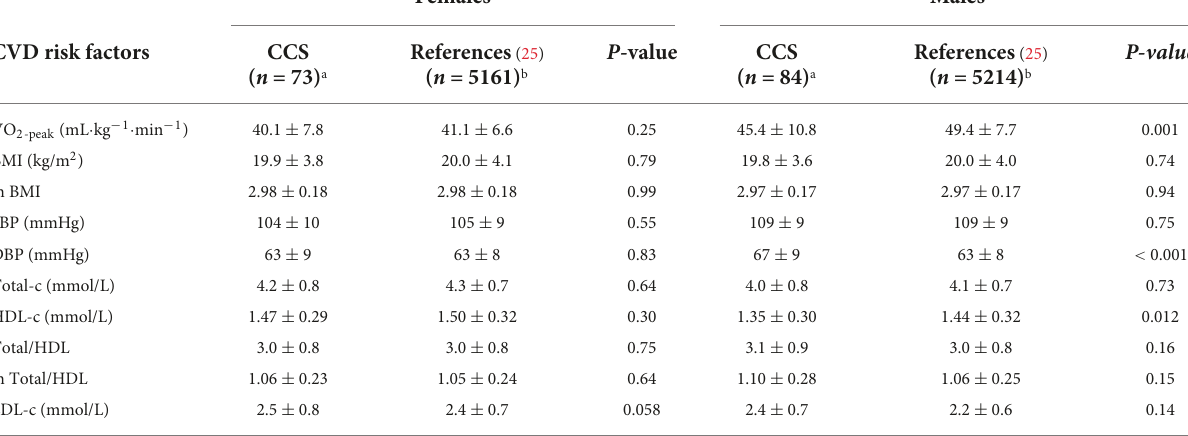
TABLE 2 Comparison of single CVD risk factors in CCS vs. references, stratified by sex.